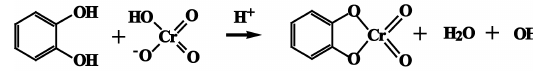
Figure 35. Adsorption of some metal ions from a HEPES buffer solution by crosslinked grape gel at different equilibrium pH values [36]. (With permission for reuse from Elsevier B.V.).